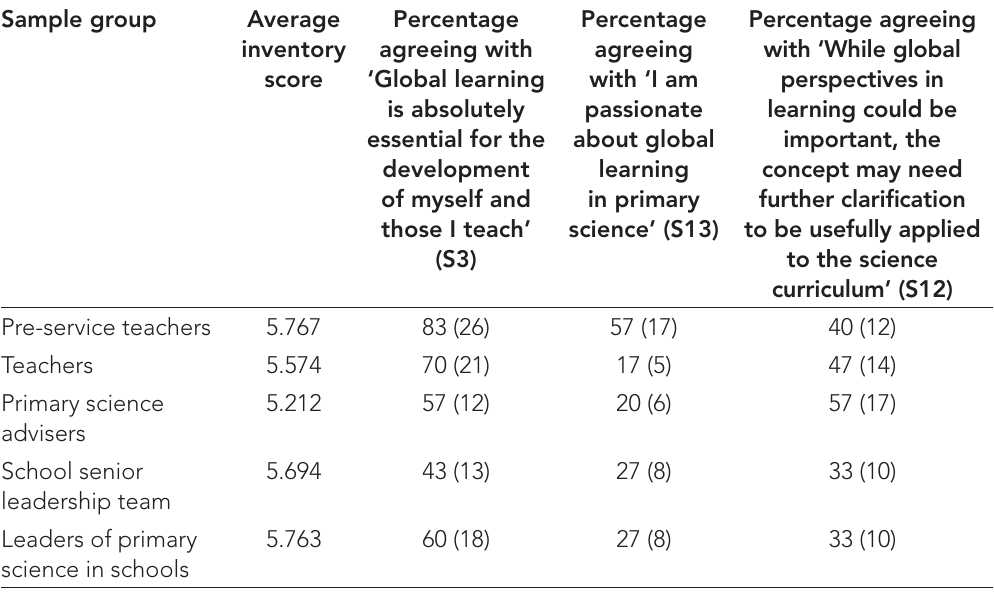
table 4: responses from the GlpS attitudinal survey (Source: author, 2020) Sample